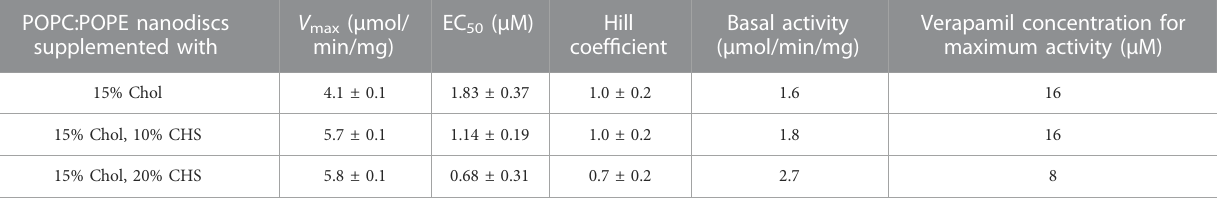
TABLE 6 Pgp was reconstituted into lipid nanodiscs prepared from POPC/POPE with the indicated concentrations of CHS and the verapamil stimulation ofATPase activity was assayed ( n = 3). POPC:POPE nanodiscs supplemented